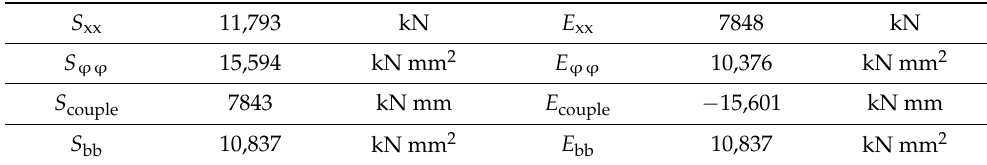
Table 5. Stiffness parameters S ij and E ij from the full cable model with quadratic tetrahedral elements (mesh size of 0.75 mm) and cable length per strand length of 1.2.